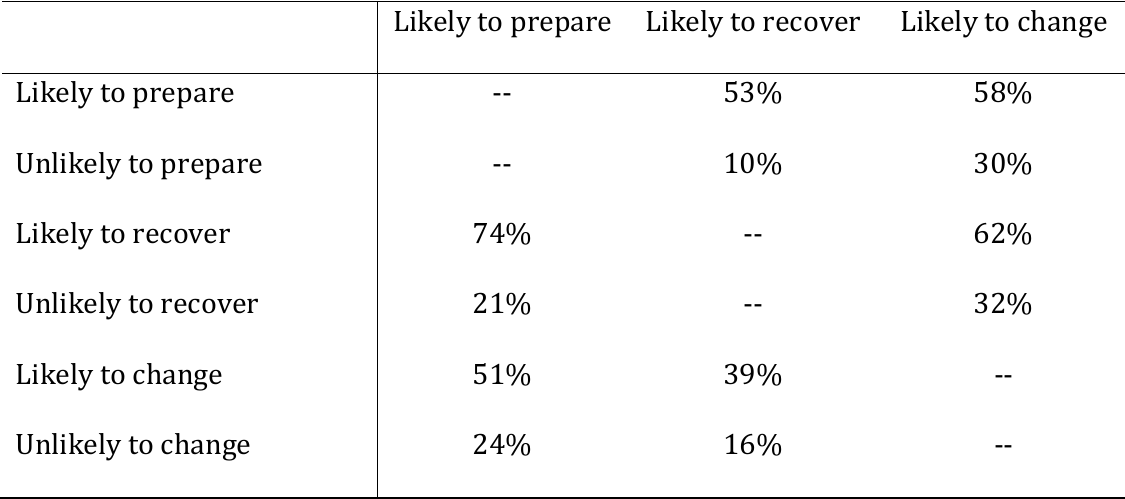
Fig. A1.3. Cross tabulations of the dichotomized dimensions of resilience-related capacities.